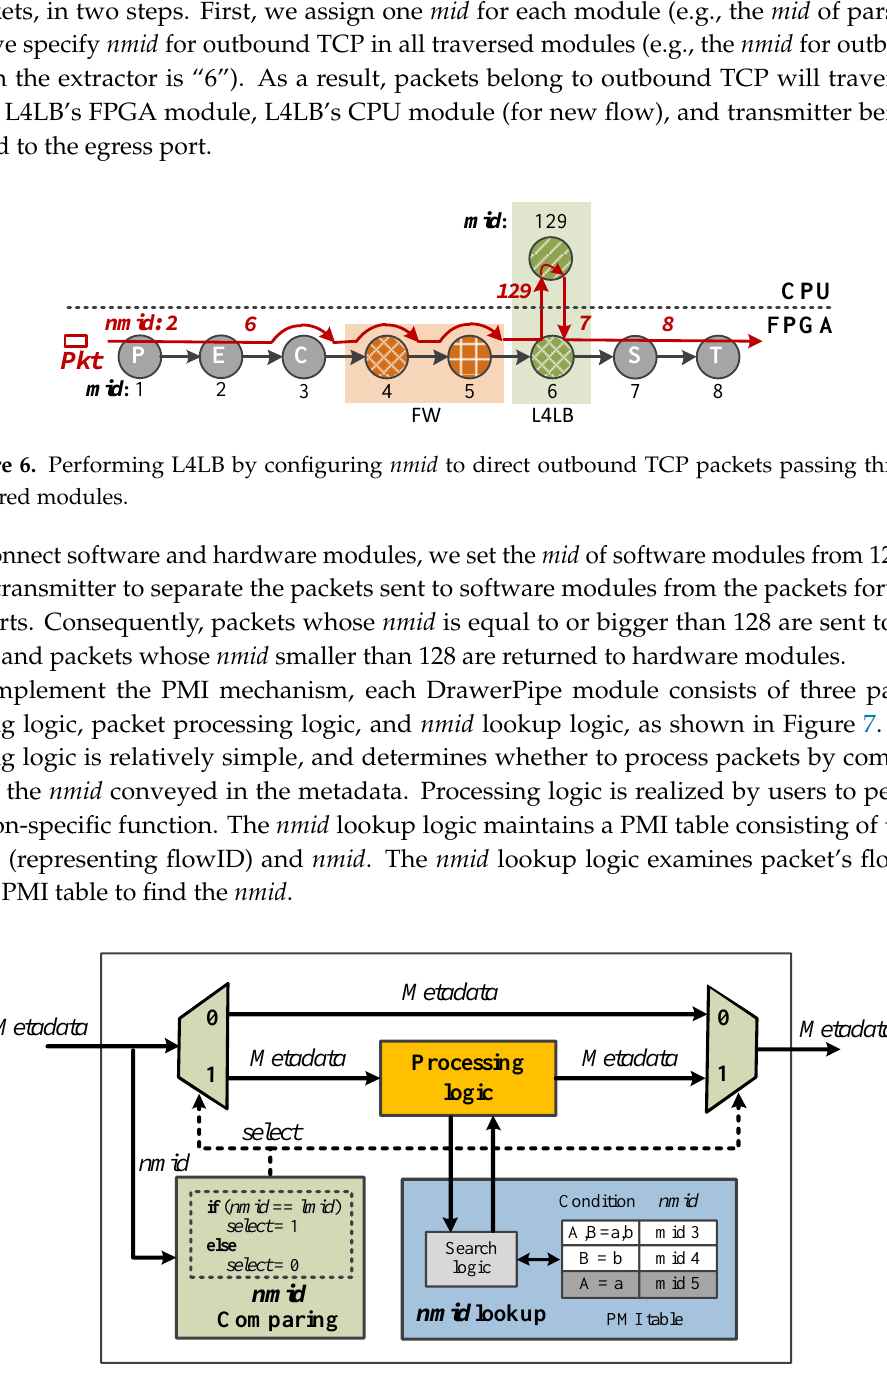
Figure 7. Each DrawerPipe module contains three parts: nmid comparing, packet processing, and nmid lookup